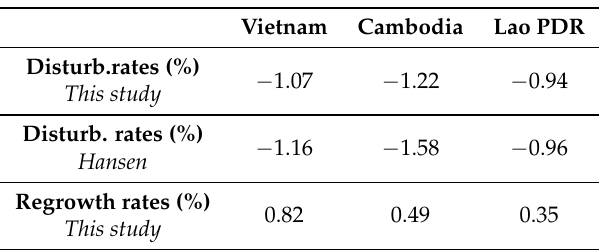
Table 3. Assessment of the disturbance rates in Vietnam, Cambodia and Lao PDR in this study and by Hansen et al. [9] between 2007 and